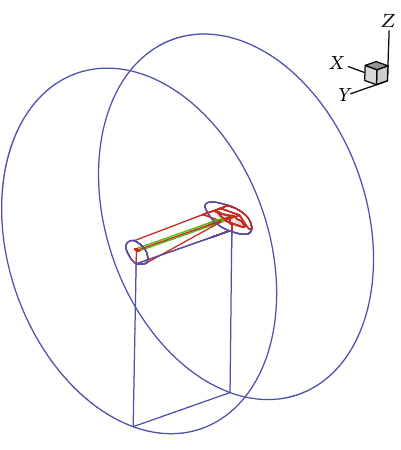
Figure 2: Gird topology. Figure 3: Fuselage, wing, and symmetry plane